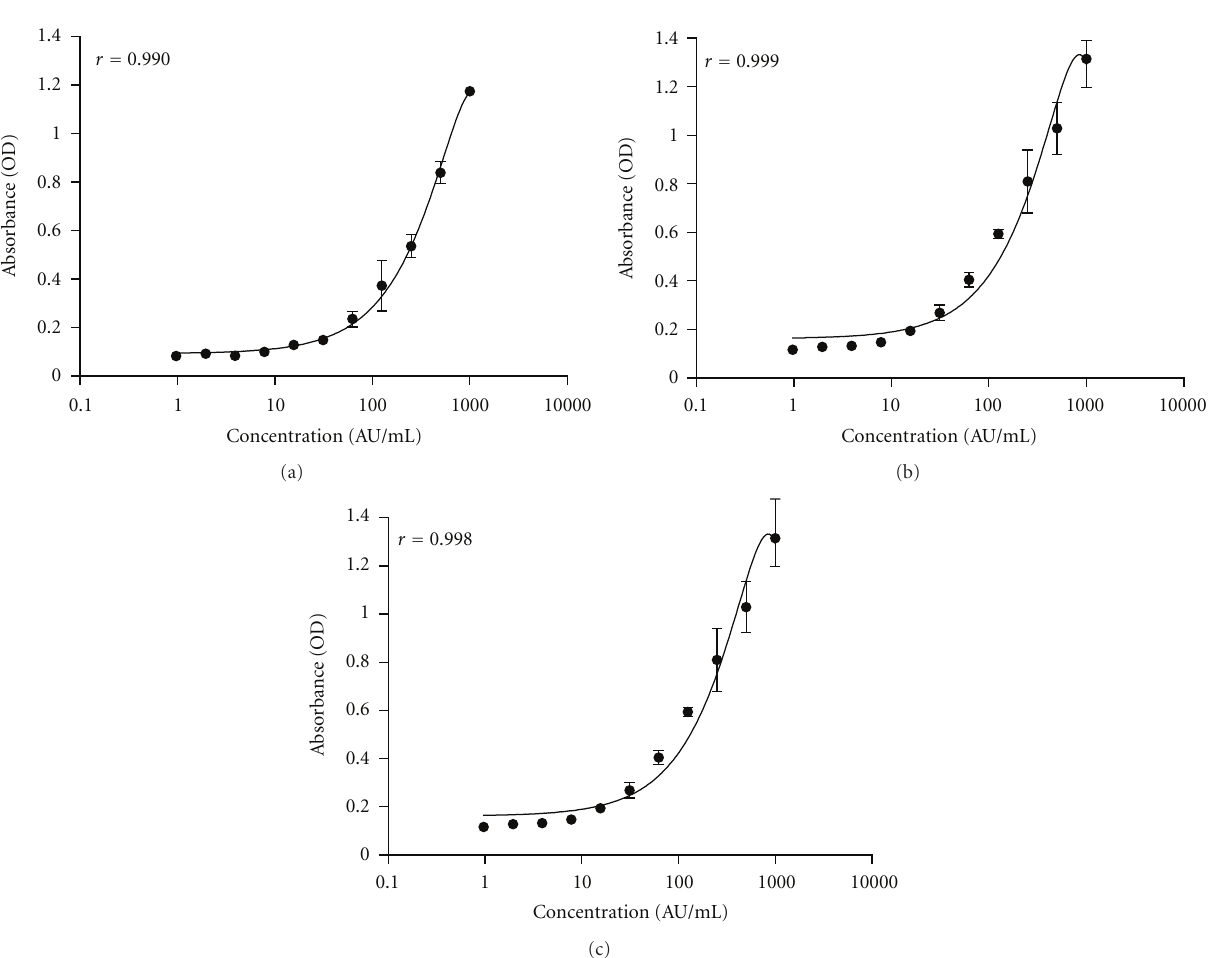
Figure 2: Representative reference curves of IgA antibodies to Dermatophagoides pteronyssinus (Dpt) (a) and its major allergens Der p1 (b) and Der p2 (c) in saliva samples. A pool of saliva samples with high levels of specific IgA antibodies for each allergen and established as containing 1000 arbitrary units per milliliter (AU/mL) was used for each reference curve, using serial double dilutions ranging from 1000 to 0.977 AU/mL. The curves were constructed with the GraphPad Prism 5.0 software by plotting the absorbance (OD) and concentration (AU/mL) values, using the quadratic curve fit. The correlation coe ffi cients ( r ) are indicated and the detection limits for these assays